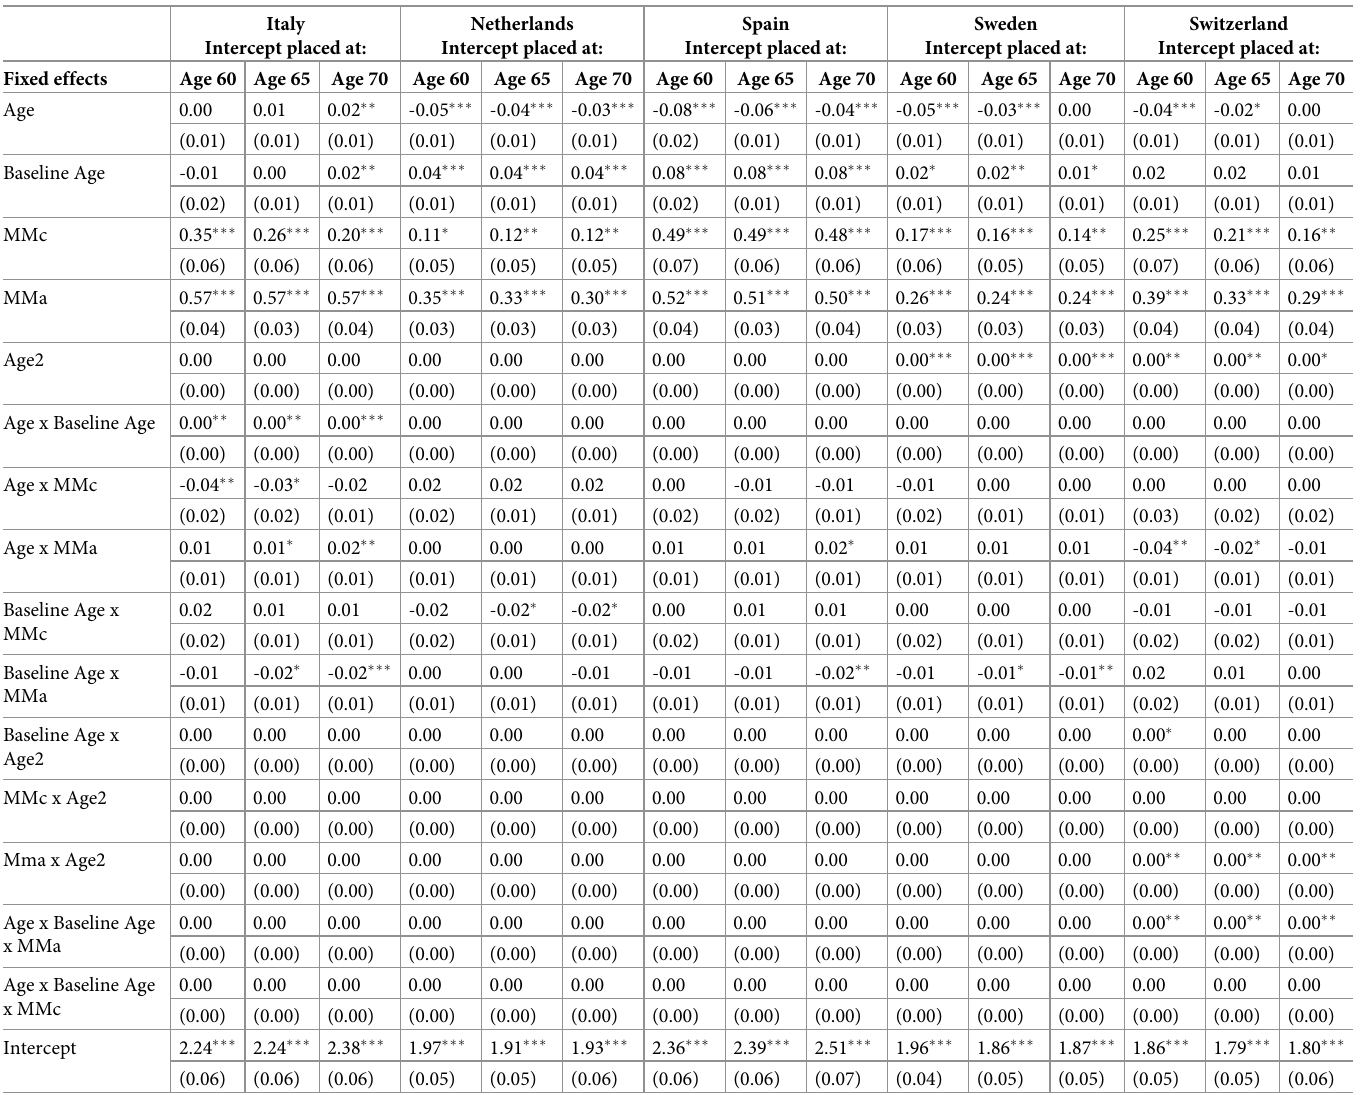
Table 3. Fixed effects estimates for EURO-D.